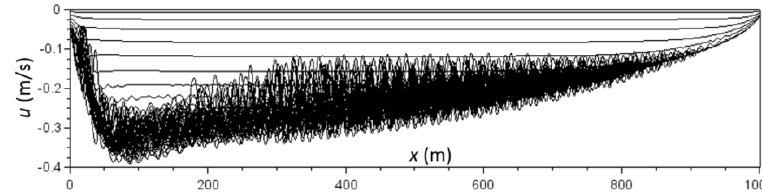
Figure 7. Scenario A ( N = 0) with τ x = −0.1 Pa. Evolution of horizontal velocity u (m/s) at the surface shown every 10 min of the simulation.